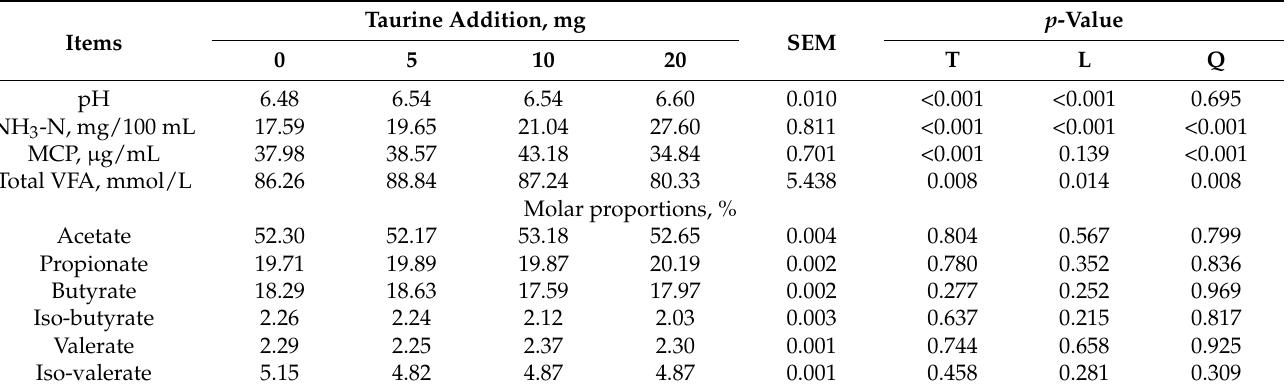
Table 5. Effect of taurine on in vitro rumen fermentation (Trial